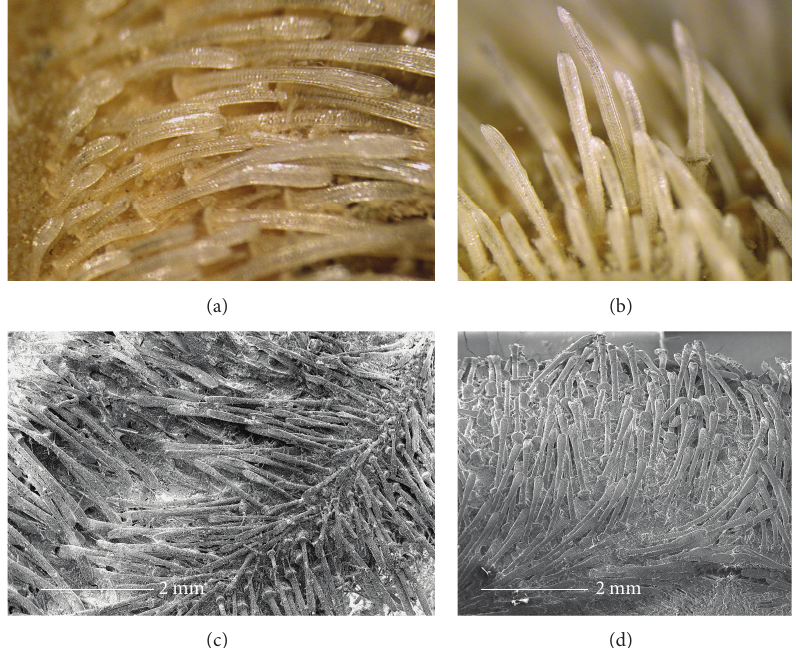
Figure 7: Dorsal supportive spines of Brisaster fragilis . ((a) and (b)) Stereomicroscope photograph; ((c) and (d)) SEM